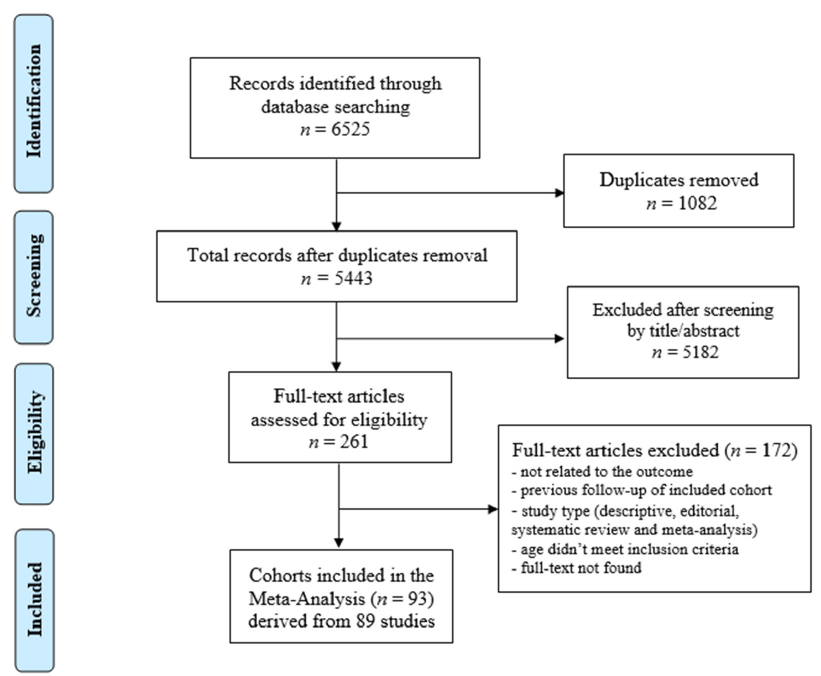
Figure 1. Preferred reporting items for systematic reviews and meta-analyses .